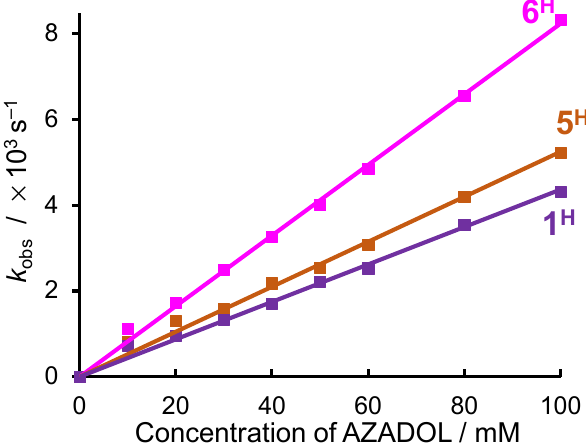
Figure 7. The plot of the concentration of AZADOL versus k obs of 1 H , 5 H , and 6 H .